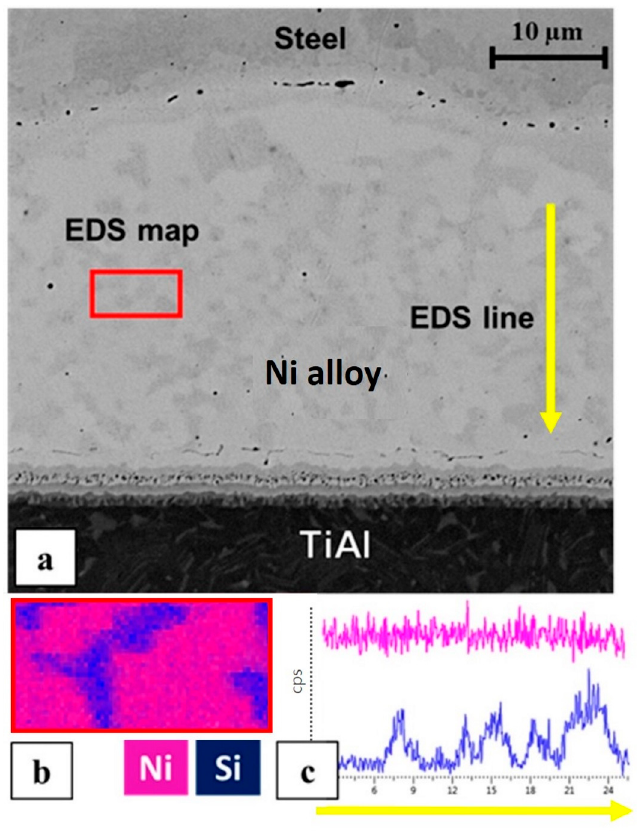
Figure 2. ( a ) back-scattered electrons image of the joint; ( b ) EDS map; ( c ) EDS line.